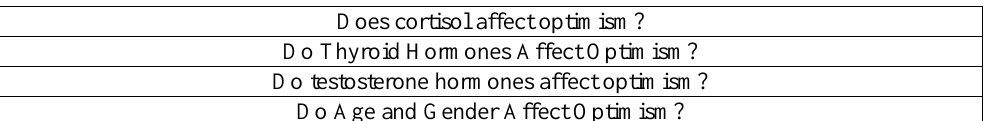
Table 2. Research